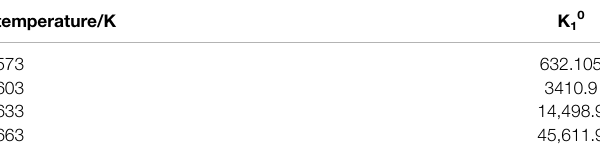
TABLE2| ComparisonofequilibriumconstantsofNd 3+ regiongeneratedbyNdF 3 at different